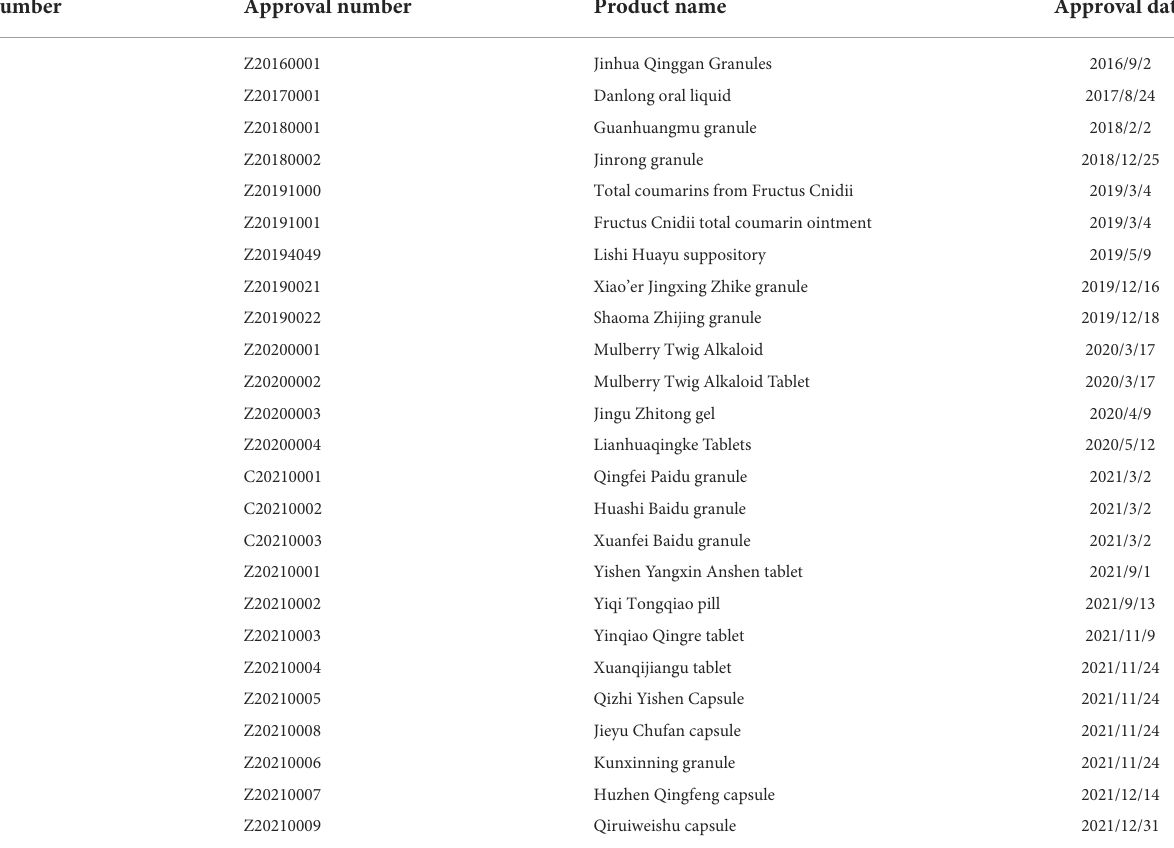
TABLE 4 New TCMs approved in mainland China from 2016 to